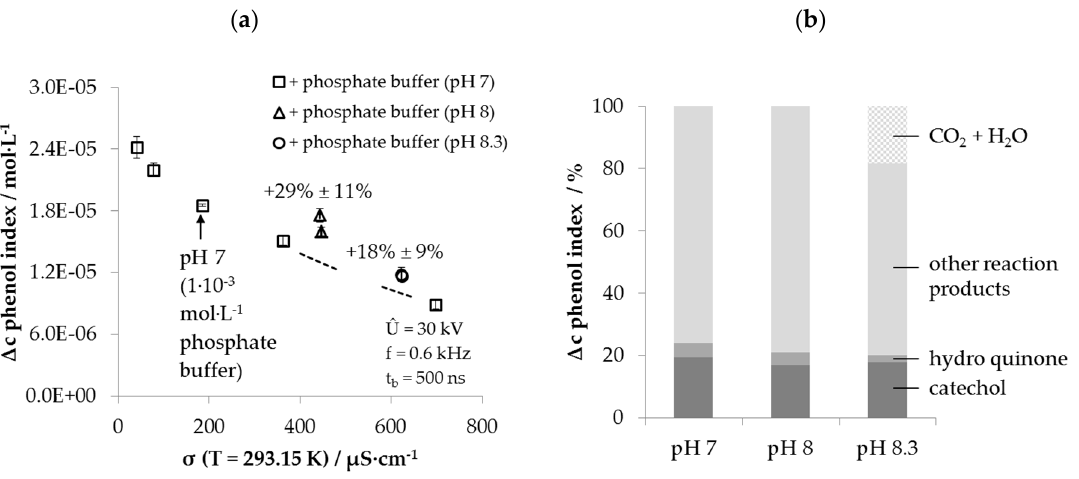
Figure 11. ( a ) Decrease of phenol index concentration ( Δ c ) to electric conductivity σ in phosphate buffer matrix at pH 7, pH 8, and pH 8.3 and ( b ) relative stoichiometric composition of Δ c phenol index after treatment determined by high-performance liquid chromatography (HPLC) and dissolved organic carbon (DOC) analysis.